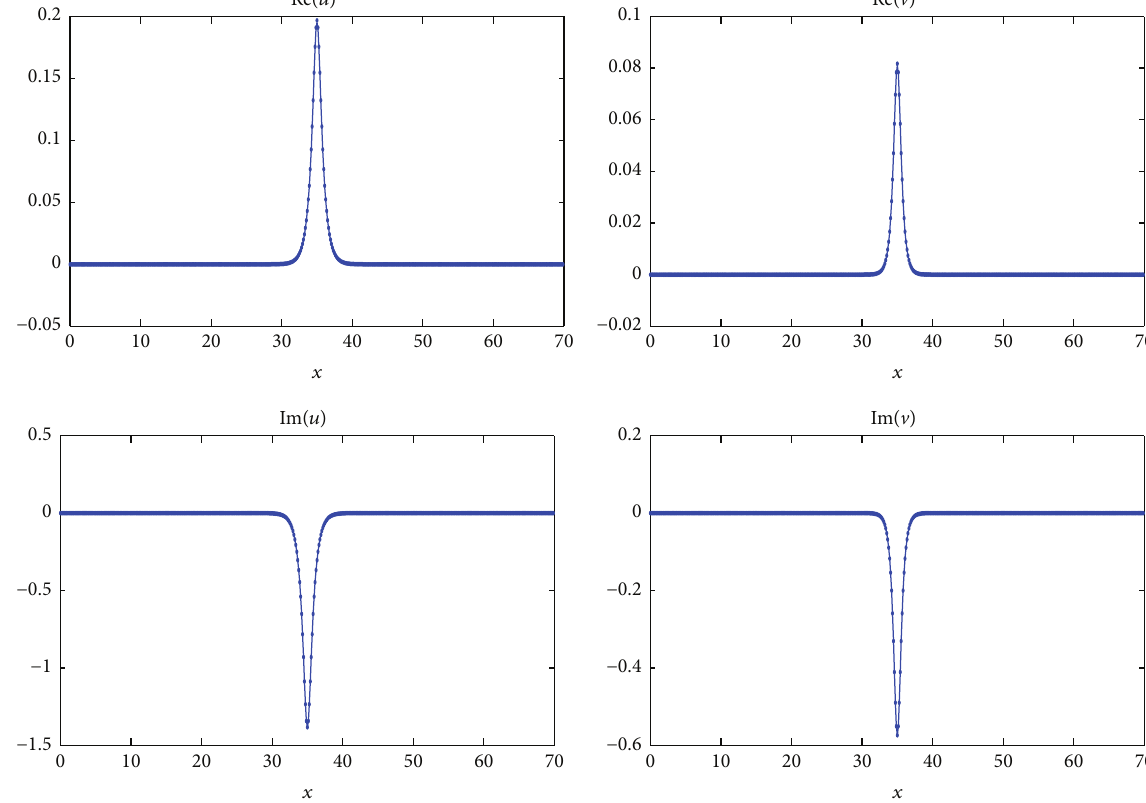
Figure 2: Real and imaginary parts of the vector soliton (𝑢, V ) of system (1) at 𝜉 = 20 . Solid line: numerical solution (𝑢, V ) of system (1) using the numerical scheme in [37]. Pointed line: expected soliton computed using